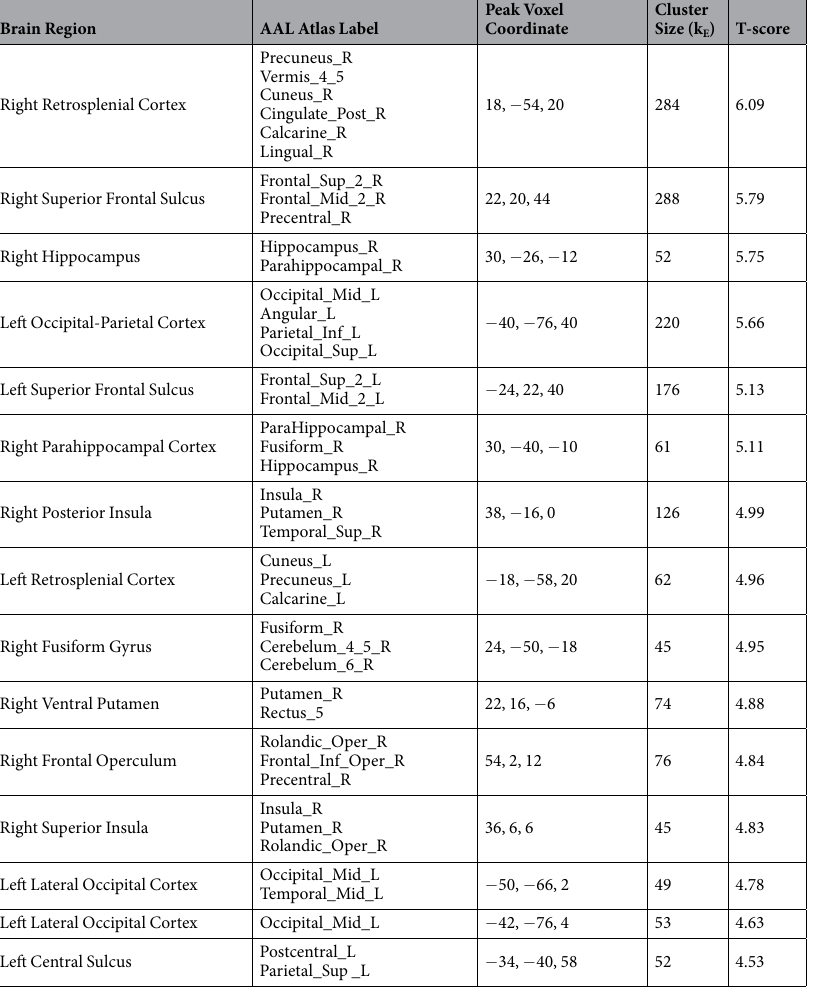
Table 2. fMRI Results: Emotion vs.